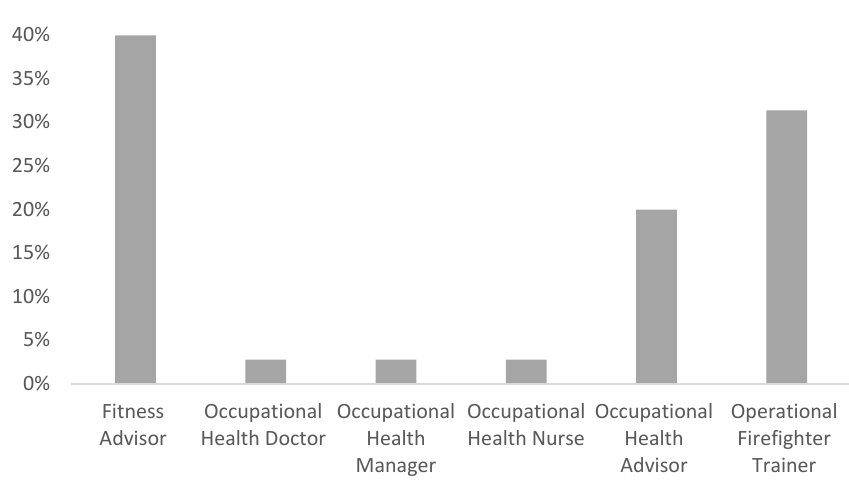
Figure 1. Bar Chart showing the job role of the participants.